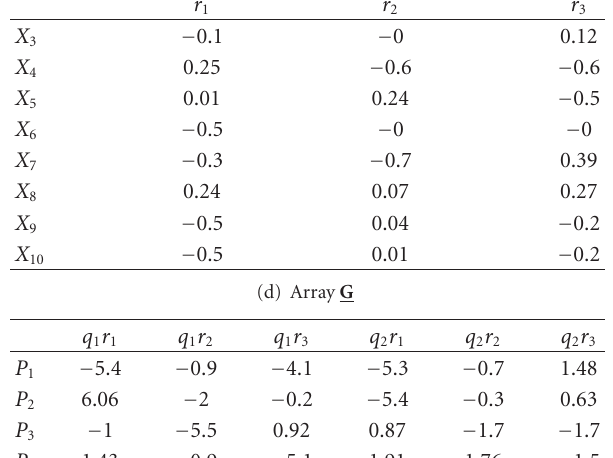
Table 2: 5 × 2 × 3 solution for SREG model with multiples